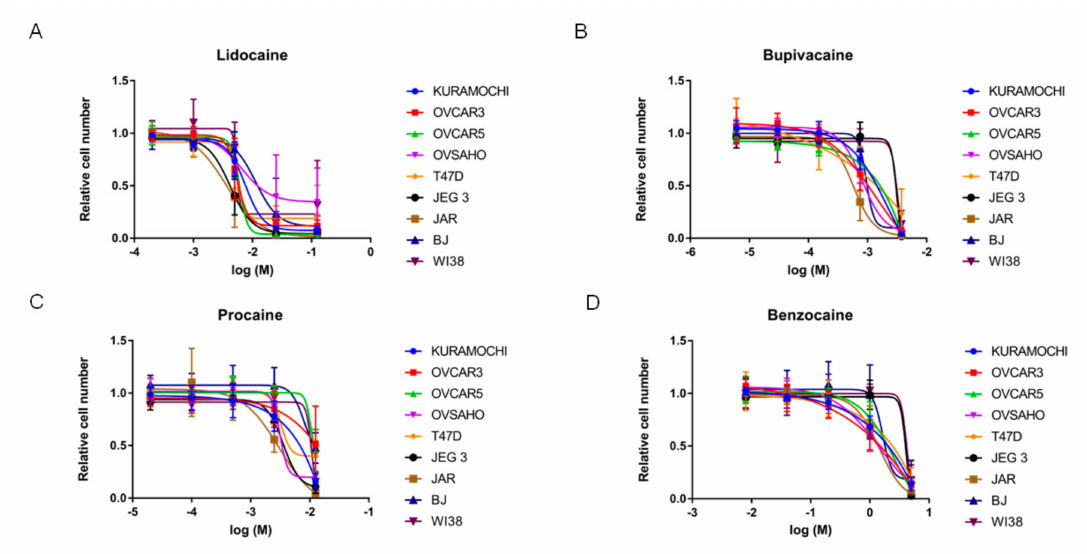
Figure 4. Concentration-dependent effects of local anesthetics on cell proliferation in various cell lines for ( A ) lidocaine, ( B ) bupivacaine, ( C ) procaine, and ( D )